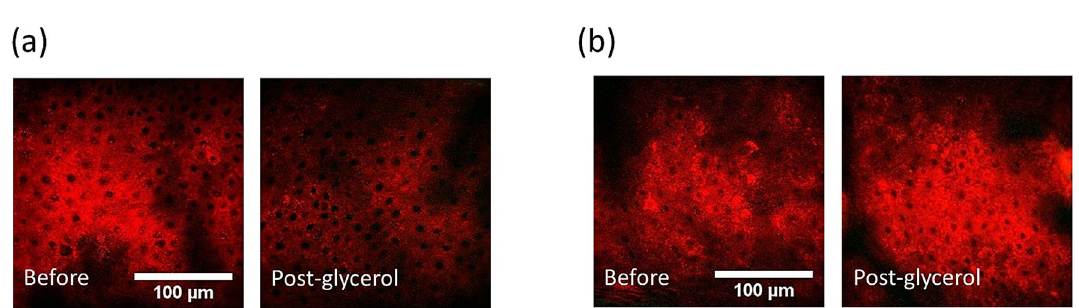
Figure 6. Optical clearing with 50% glycerol immersion. ( a ) SHG images of dermis (scale bar = 100 μm), and ( b ) bright field images. (scale bar = 1 mm). This example belongs to Case E50-I90-2. Before: before immersion; Post-glycerol: after immersion.